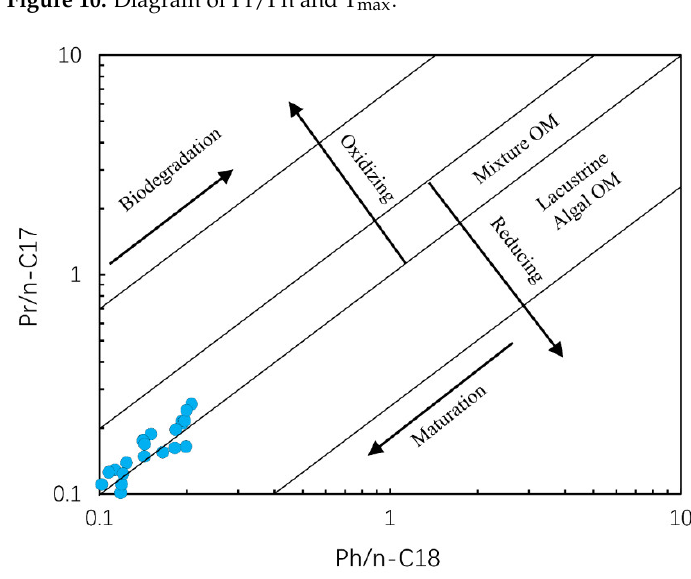
Figure 11. Diagram of Pr/ n -C 17 vs. Ph/ n -C 18 of the shale samples, showing redox conditions and organic matter sources (Adapted from Refs. [58,59]), OM = Organic matter.